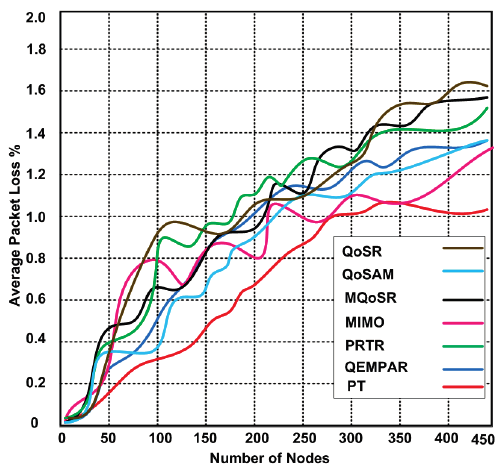
Figure 11. Average packet loss.